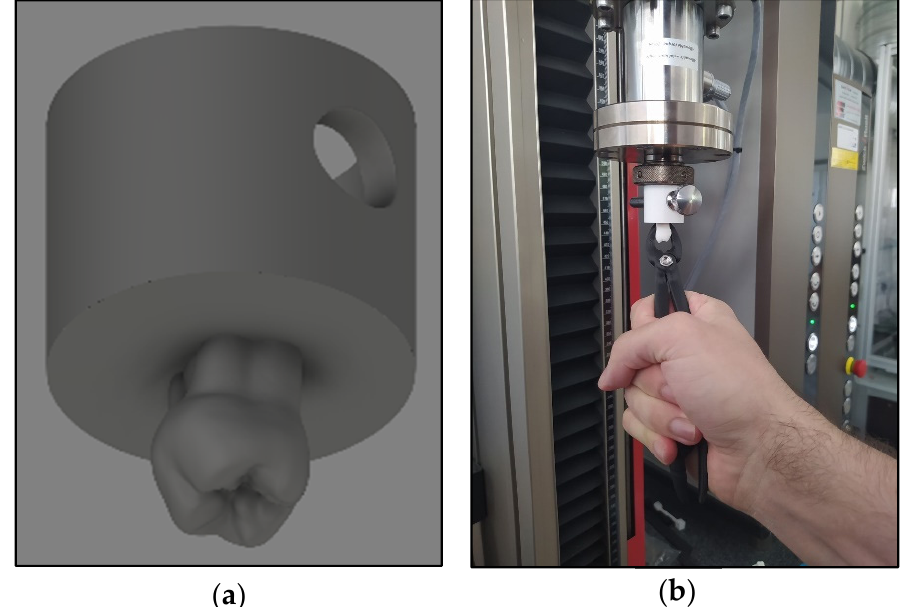
Figure 4. ( a ) The tooth model in .stl format; ( b ) the printed tooth model applied to the biaxial tester .